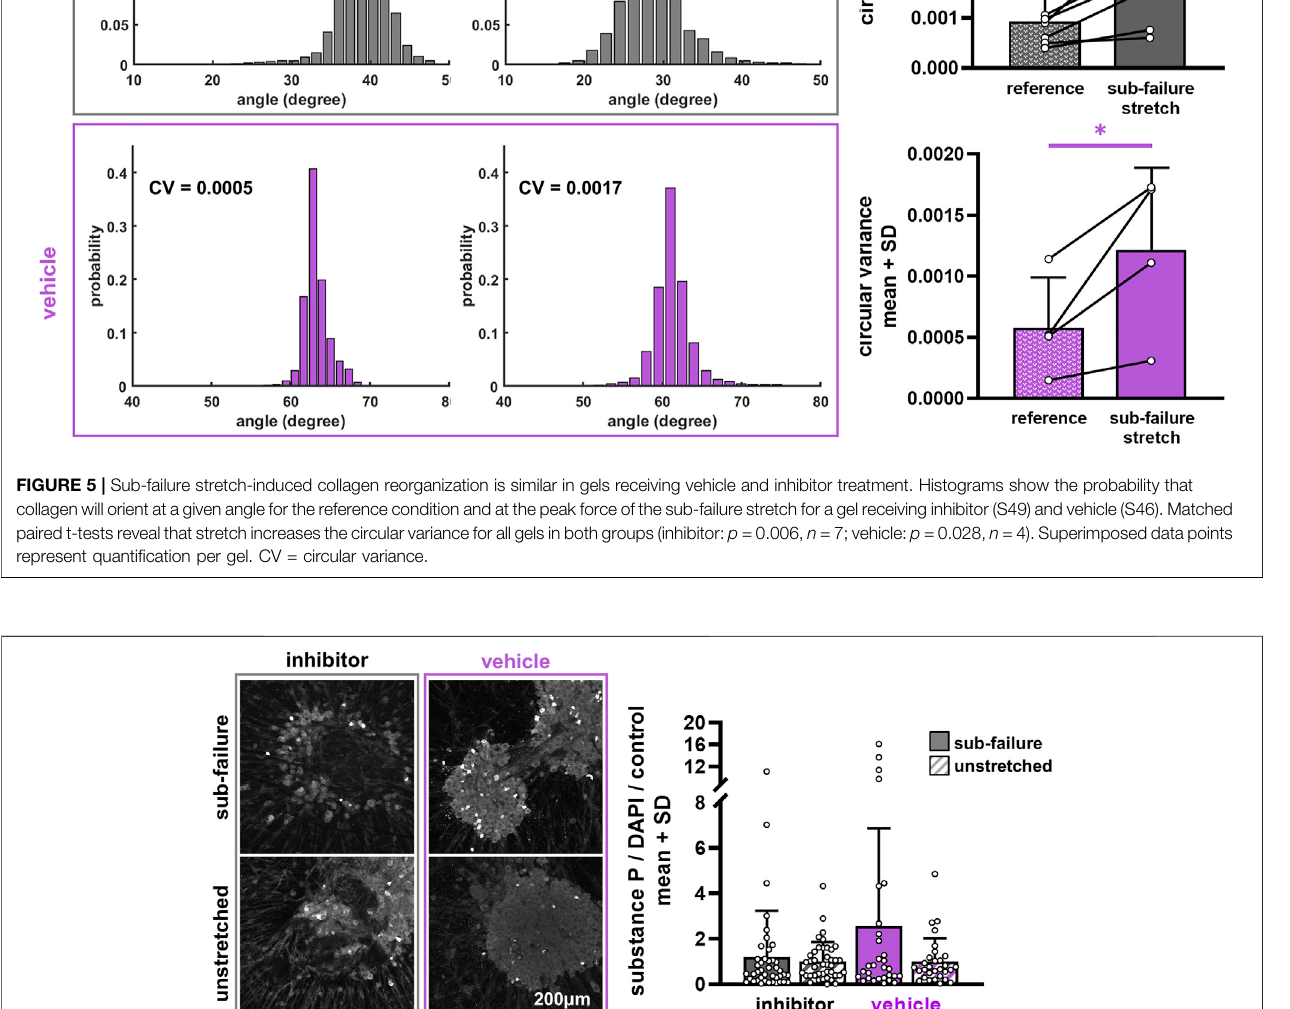
Frontiers in Mechanical Engineering |